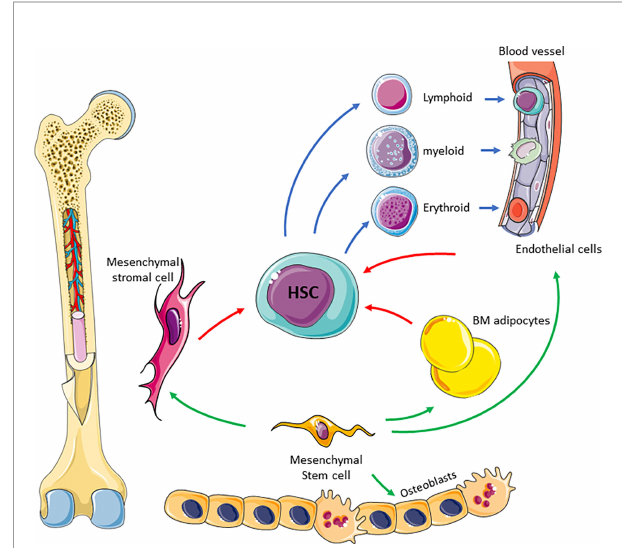
FIGURE 1 | Schematic of BM niche. The complexity of the niche is highlighted showing many cell types and interaction between these cells to facilitate blood production. Mesenchymal stem cells differentiate into BM adipocytes, stromal cells, endothelial cells and osteoblasts (green arrow). Mesenchymal derived cells supports HSC differentiation (red arrows) in to blood progenitor cells (blue